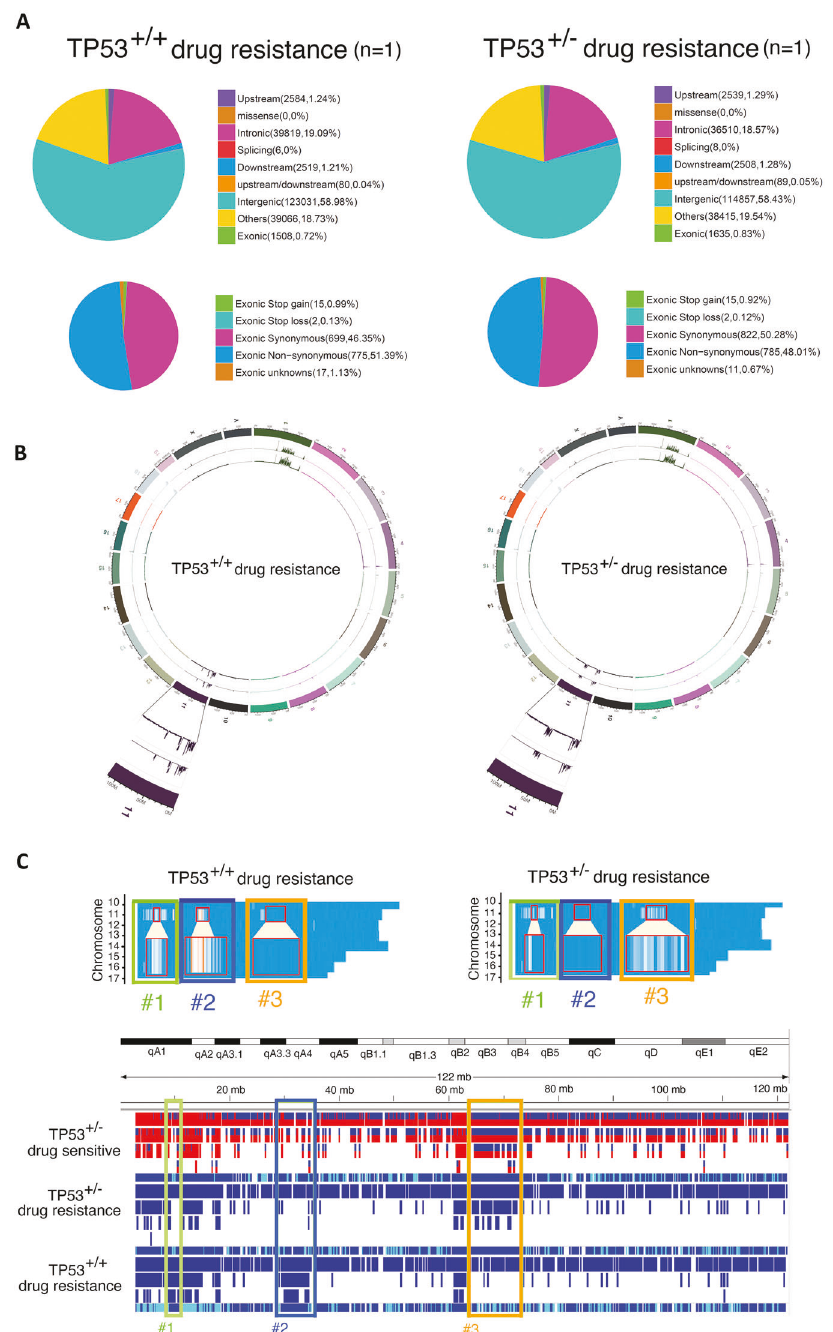
Fig. 6 The effect of Tp53 + / − on genomic mutations in drug-resistant mice. Total genomic RNA was isolated from lung tissues of drug- resistant mice ( EGFR L858R ) with or without the Tp53 + / − genotype, EGFR L858R *Tp53 + / + ( n = 1) and EGFR L858R *Tp53 + / − ( n = 1), for whole-genome sequencing (WGS). The percentages of sequence mutations in the various regions of the whole-genome sequence (WGS) are shown here ( A ). The SNP and InDel pro fi les in drug-resistant mice with or without the TP53 + / − mice were used to study the related pathways by Circus plot. The Chromosome 11 was highlighted ( B ). Genes with nonsynonymous mutations in the Chromosome 11 of drug-resistant mice with or without Tp53 + / − were shown here in detail ( C ).